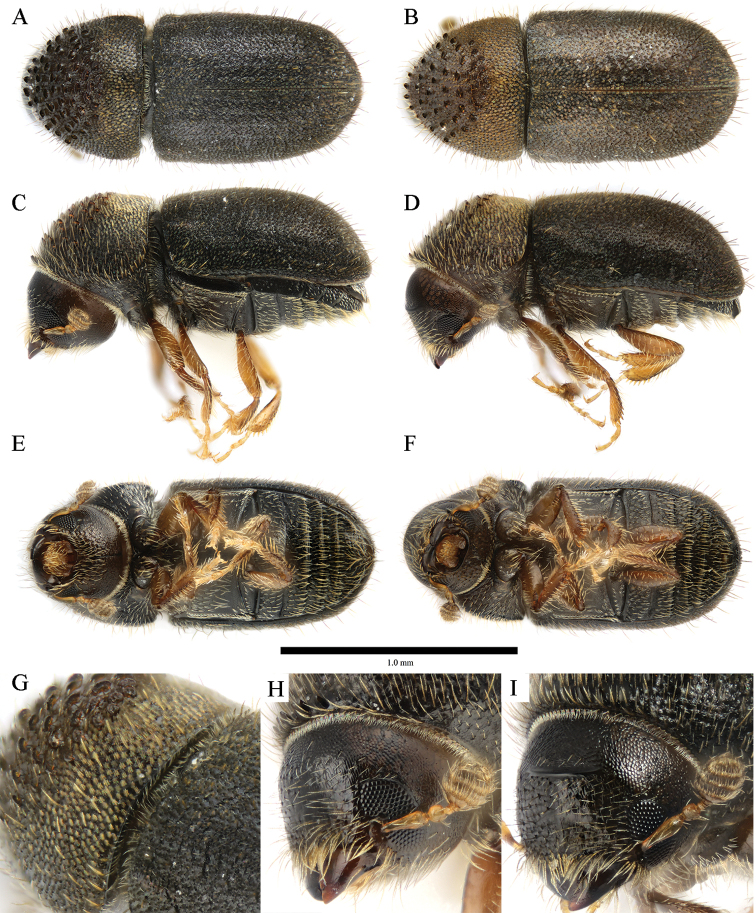
Cryphalus
morivorusA, C, E, G, H holotype, female, UFFE:31722 B, D, F, I paratype, male, UFFE:31723.